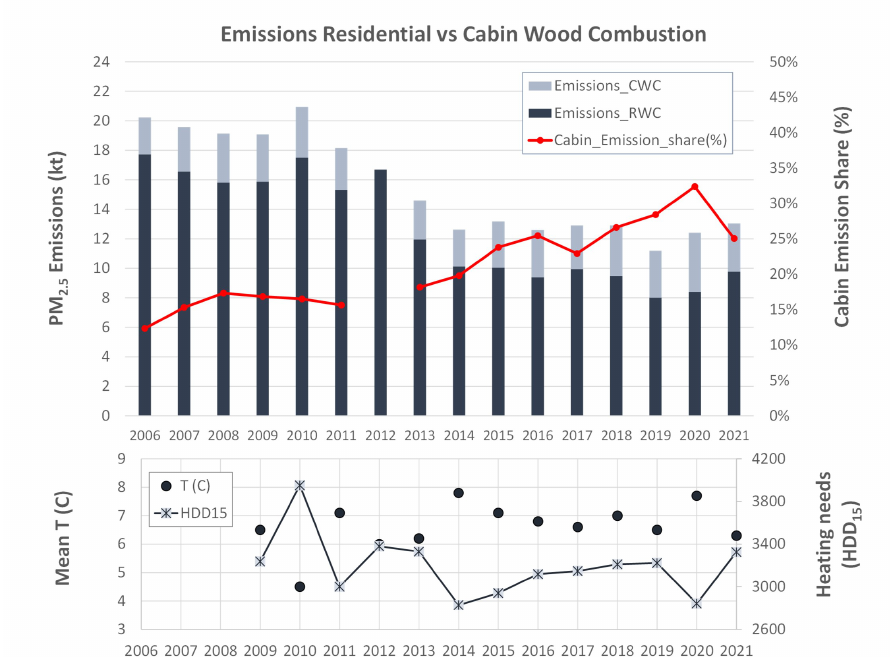
Figure 5. ( Top ) Annual PM 2.5 emissions from wood burning from heating at residencies (RWC) and cabin (CWC) in Norway and the share of cabin emissions to the total emissions (%). ( Bottom ) Annual mean temperature ( ◦ C) and heating need HDD 15 ), both averaged over all dwellings in